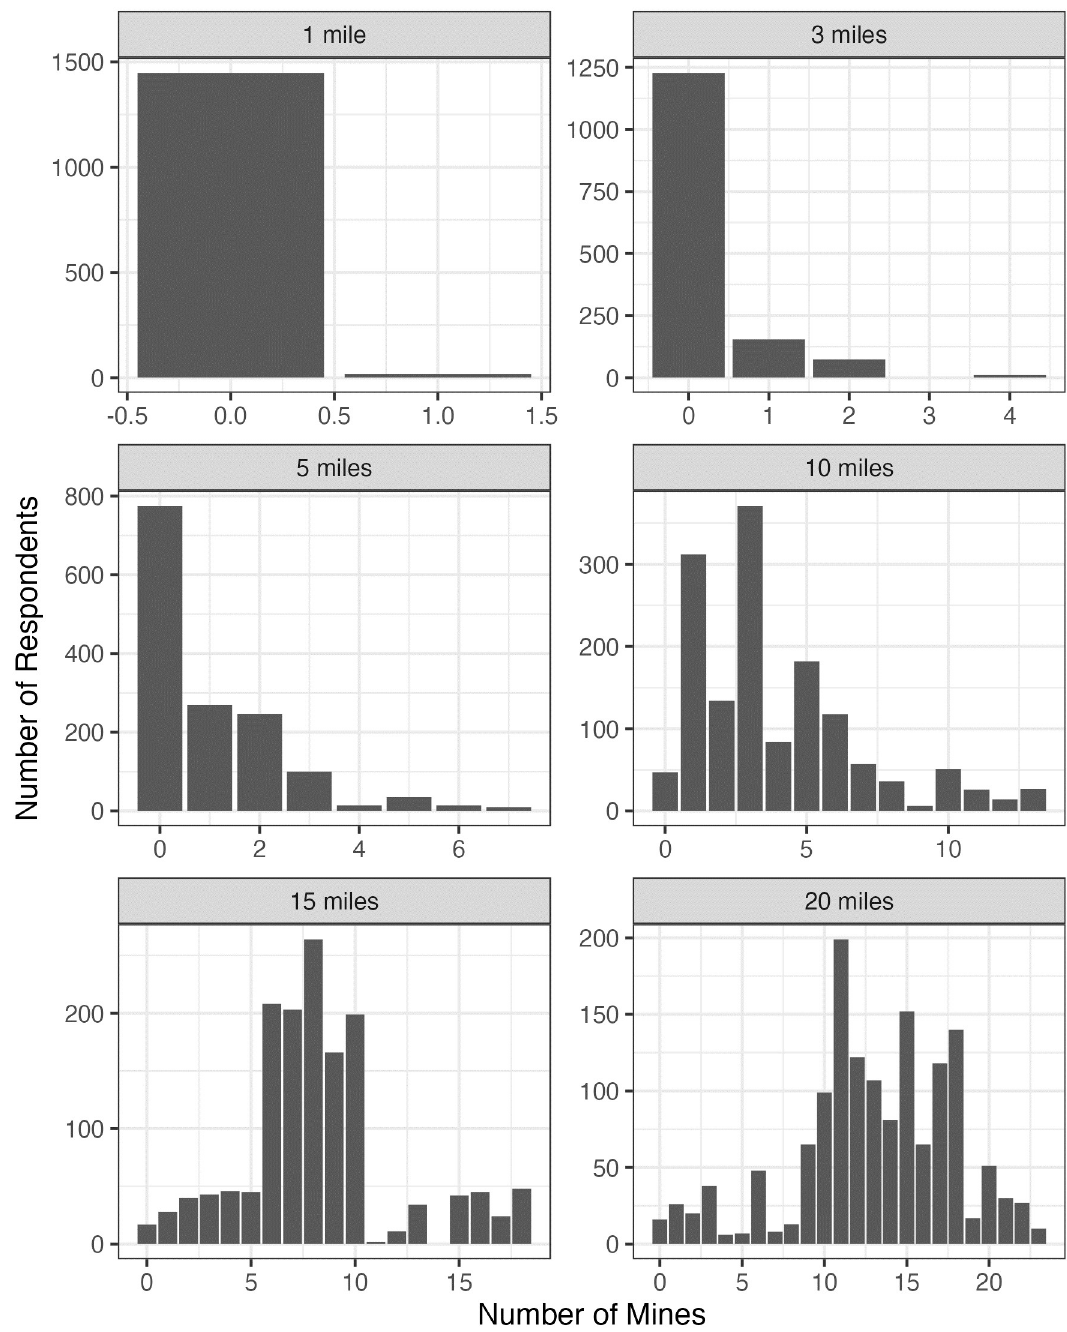
Fig 3. Geographical distribution of respondents in relation to existing